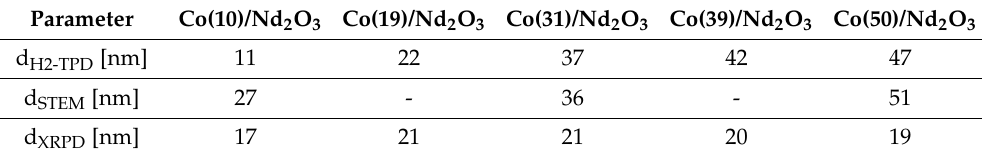
Table 3. Comparison of average Co particle and Co crystallite size in the Co/Nd 2 O 3 catalysts, determined through H 2 -TPD, XRPD and TEM.